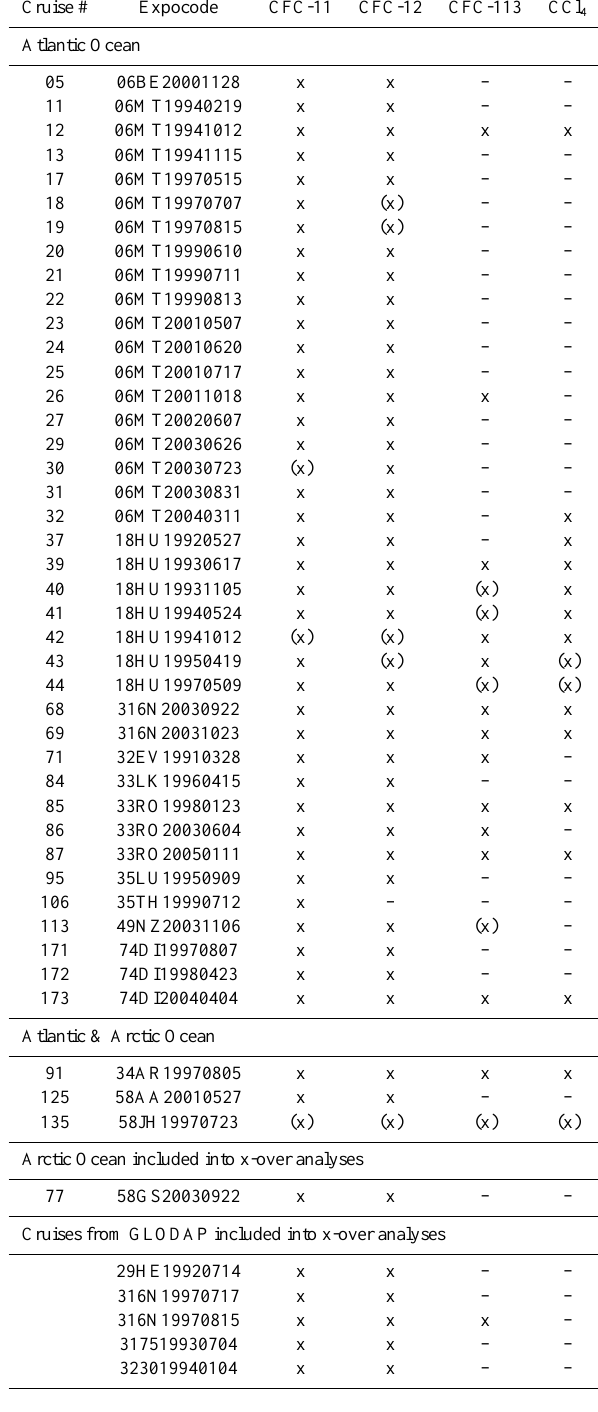
Table 1. List of all CARINA-ATL CFC data. Crosses in brackets indicate that the CFC component has been measured, but all data are flagged 3 or 4, either directly by the PI or after the QC procedure. These data are not included in the CARINA data product (Key et al.,